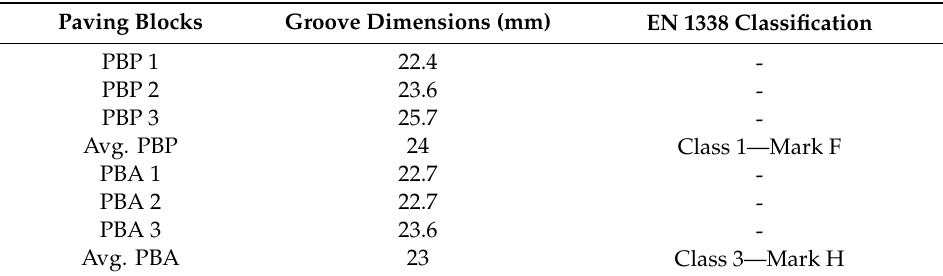
Table 6. Abrasion tests results and classification according to the EN 1338 standard.